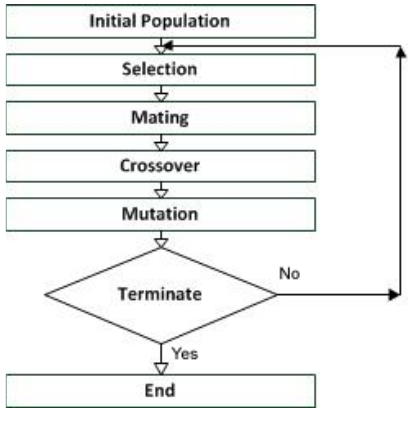
Figure 2 . Simplified flow chart of a genetic algorithm (Keet,